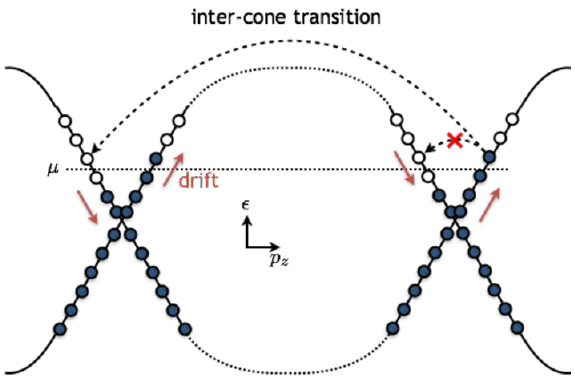
Figure 1 . In the inter-cone transition the fermion is scattered into the other cone. Since the inter- cone transition is highly dependent on its modeling, it is di(cid:14)cult to give a universal prediction.